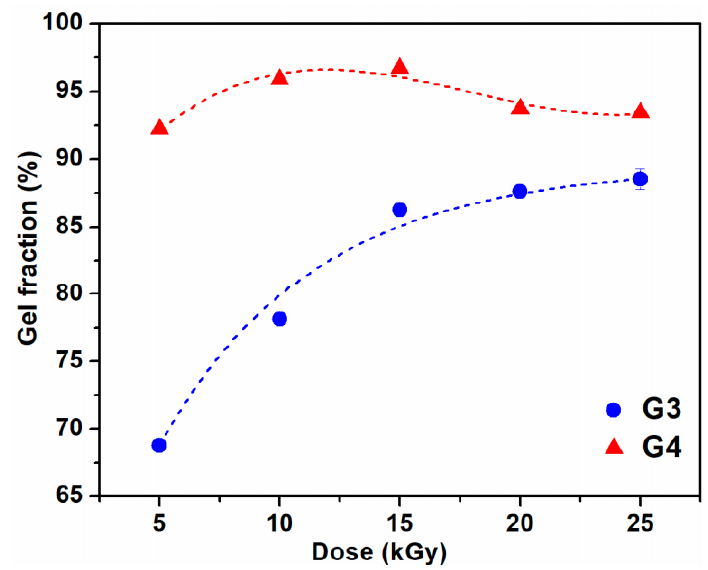
Figure 1. Gel fraction as a function of irradiation dose for G3 and G4 hydrogels.